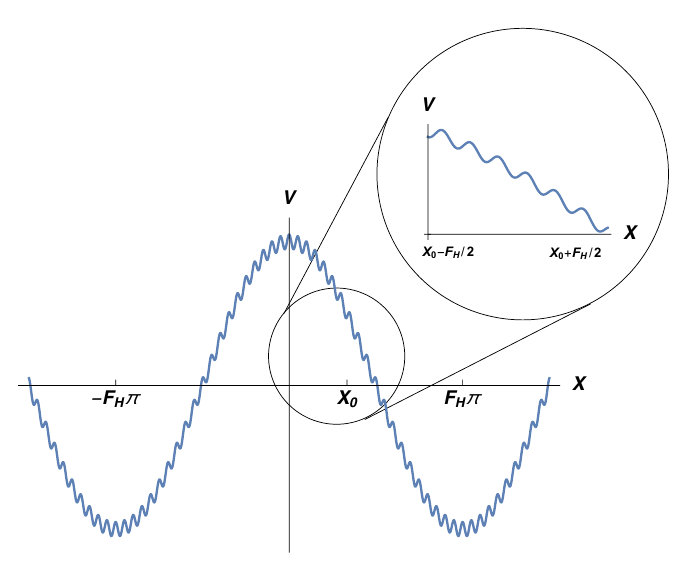
Figure 10 . An illustration of the relaxion potential of eq. (9.1) with F H = 40 F L . The small wiggle comes from the second term in eq. (9.1). The inserted (cid:12)gure is a close-up of the potential around X 0 =F H = (cid:25)=